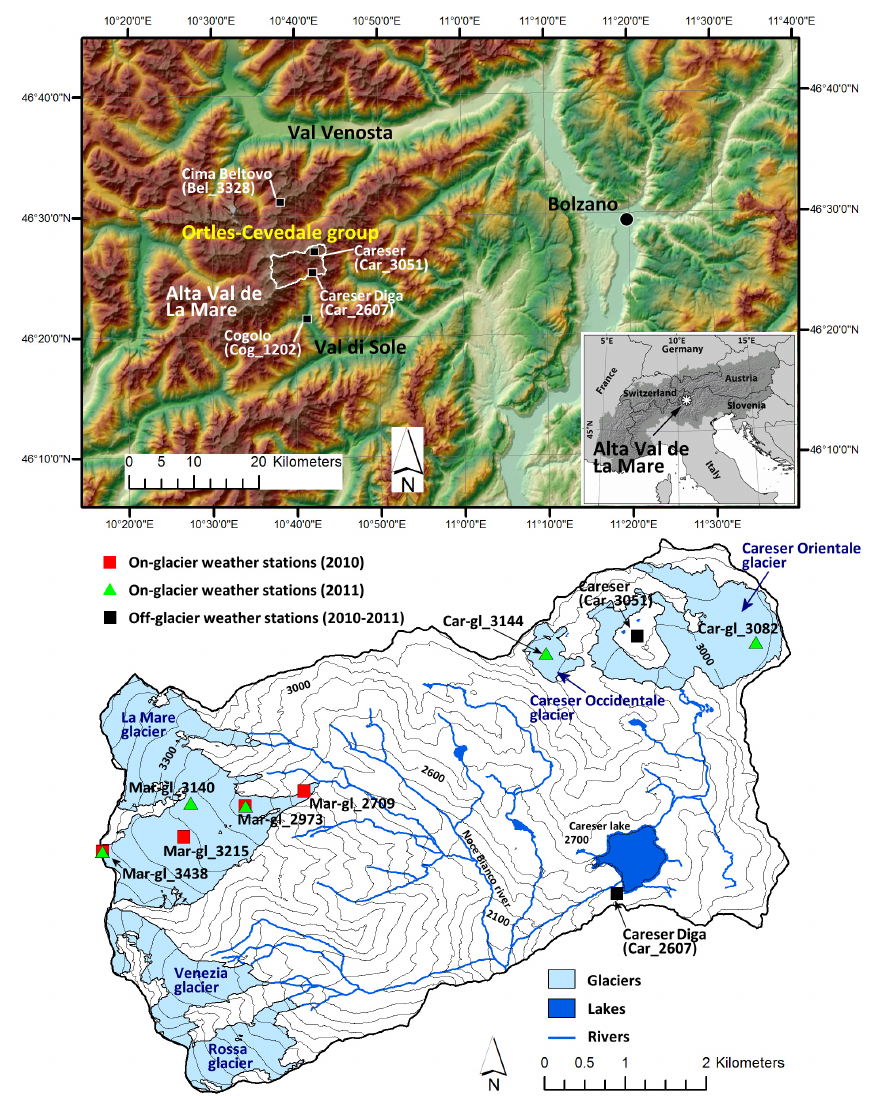
Figure 1. Geographic setting of Alta Val de La Mare and location of the automatic weather